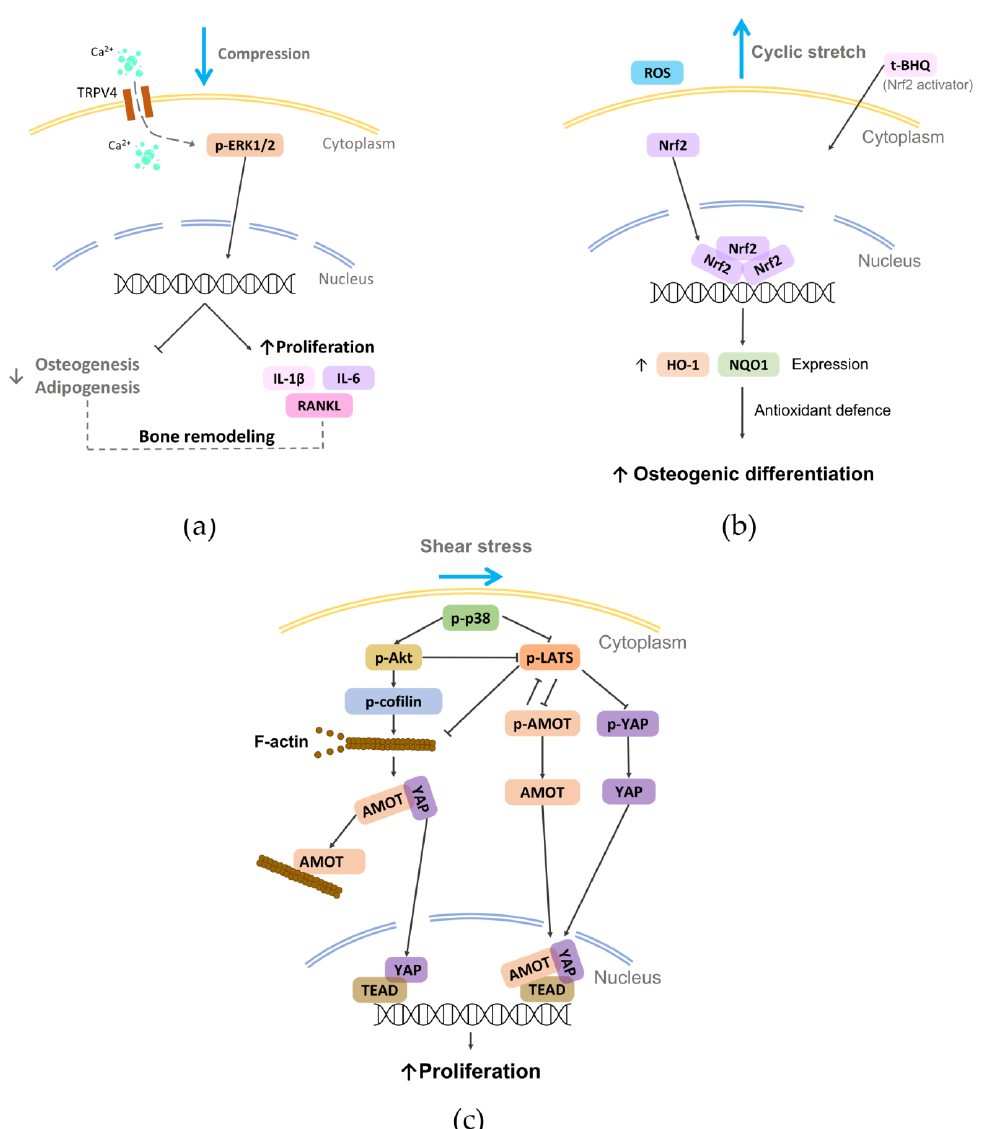
Figure 6. Schematic representation of some mechanotransduction pathways activated on PDL cells by the reported physical stimuli (i.e., compression, stretch, and shear stress). ( a ) External compression applied on rat primary PDLSCs can induce the activation of TRPV4 and consequently modulate bone remodeling [130]; ( b ) external cyclic stretch can promote the osteogenic differentiation of hPDLSCs by activating the Nrf2 [146]; ( c ) shear stress applied to hPDL cells can activate p38, which regulates the nuclear translocation YAP, promoting cell proliferation [162].